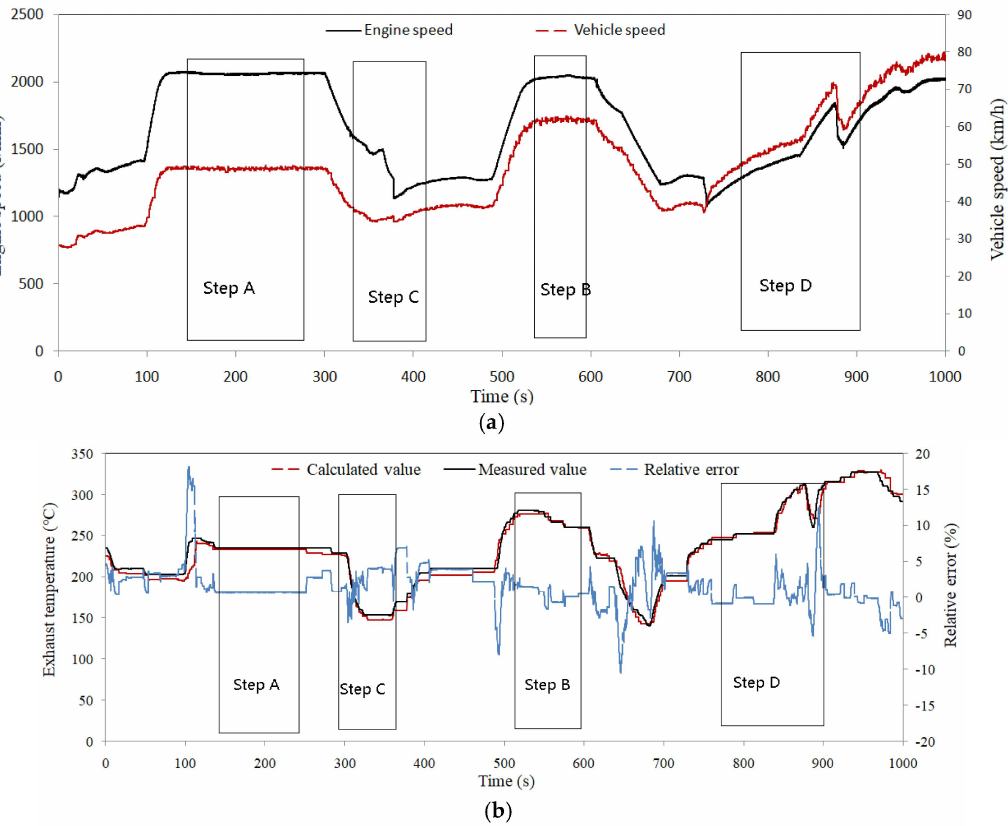
Figure 7. Exhaust temperature curve and vehicle operation data under real vehicle test conditions. ( a ) Engine speed and vehicle speed; ( b ) exhaust temperature comparison between the model calcu- lated value and the measured